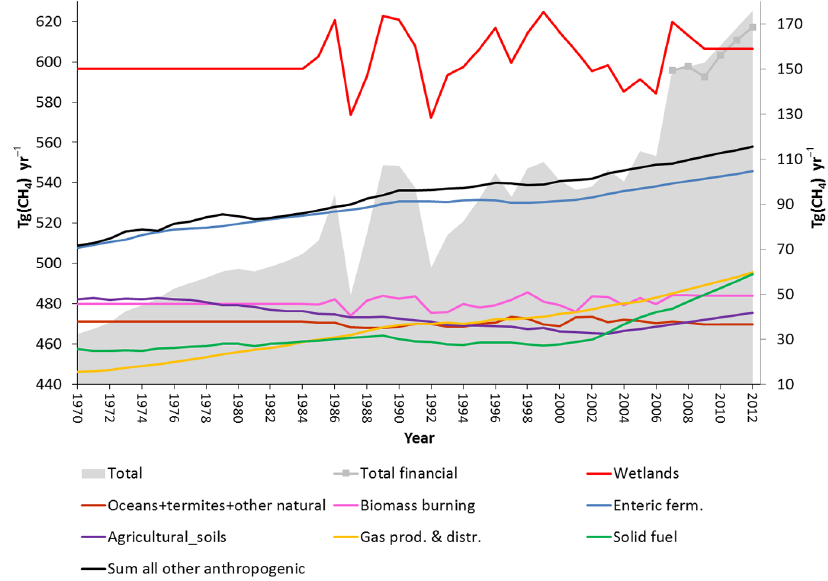
Figure 1. Emissions used in the model simulations. The grey shaded area is the total CH 4 emissions (left y axis). The total emissions in the alternative extrapolation accounting for the financial crisis are shown from 2006 and onwards as the grey line with markers. The other coloured lines are the CH 4 emissions from the main emission sectors (right y